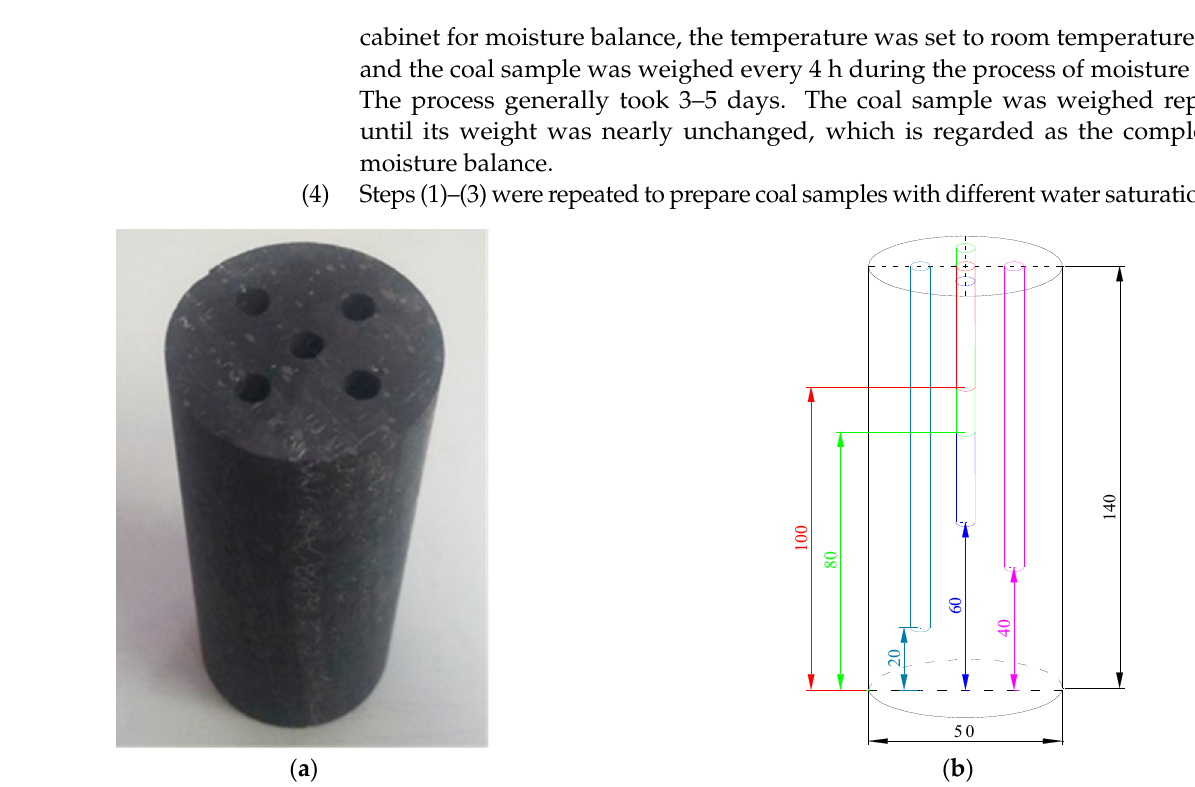
Figure 1. The test coal samples: ( a ) a photograph of a coal sample; ( b ) a diagram of coal sample drilling.